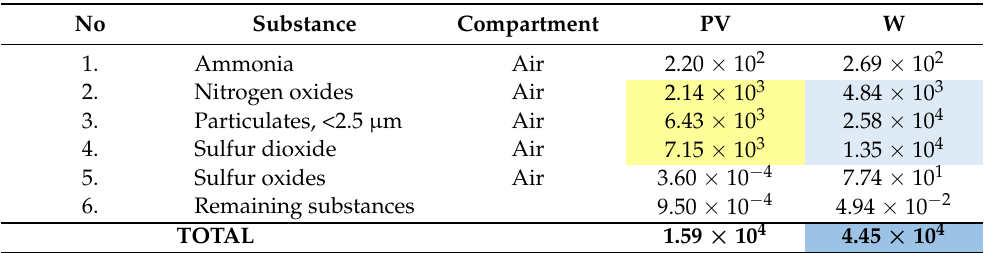
Highlight—the highest levels of negative environmental